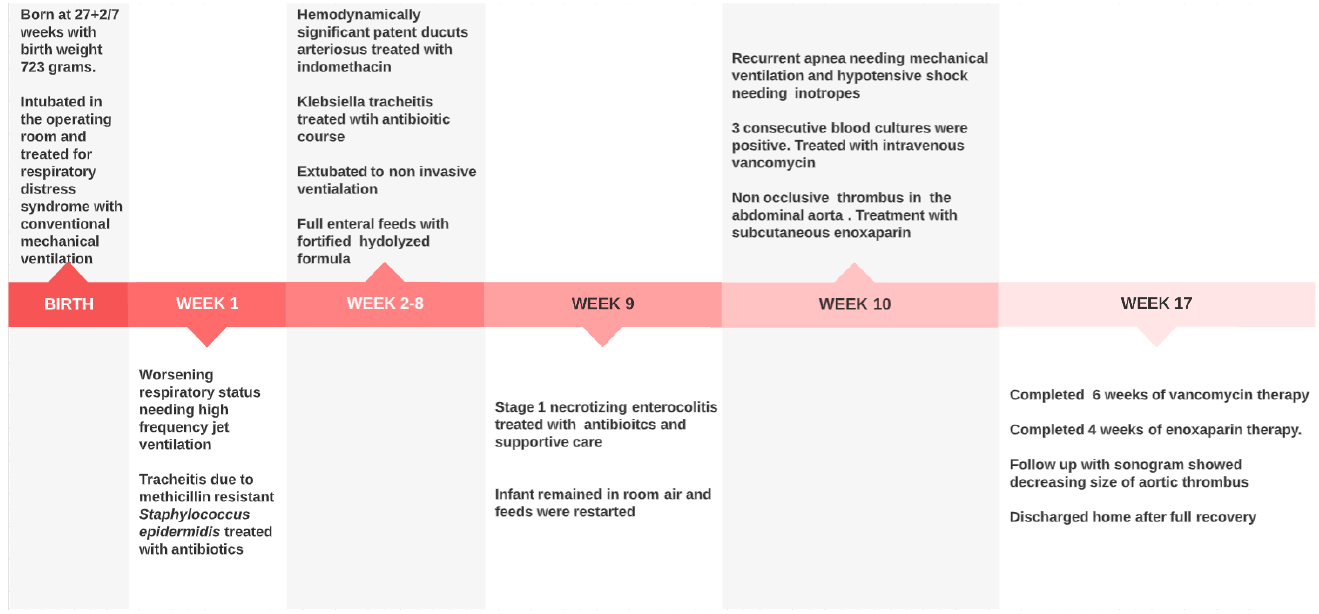
Figure 2. Sequential timeline of illness presentation.